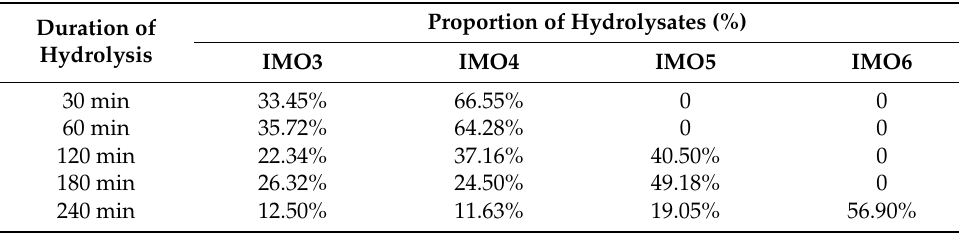
Table 2. Composition analysis of PsDex1711 hydrolysates.